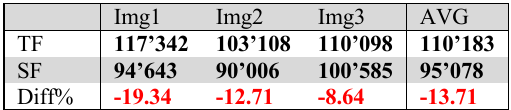
Figure 6. Pleiades VHR satellite imagery, Gray RGB with marked out Frame, Vegetation and Water.